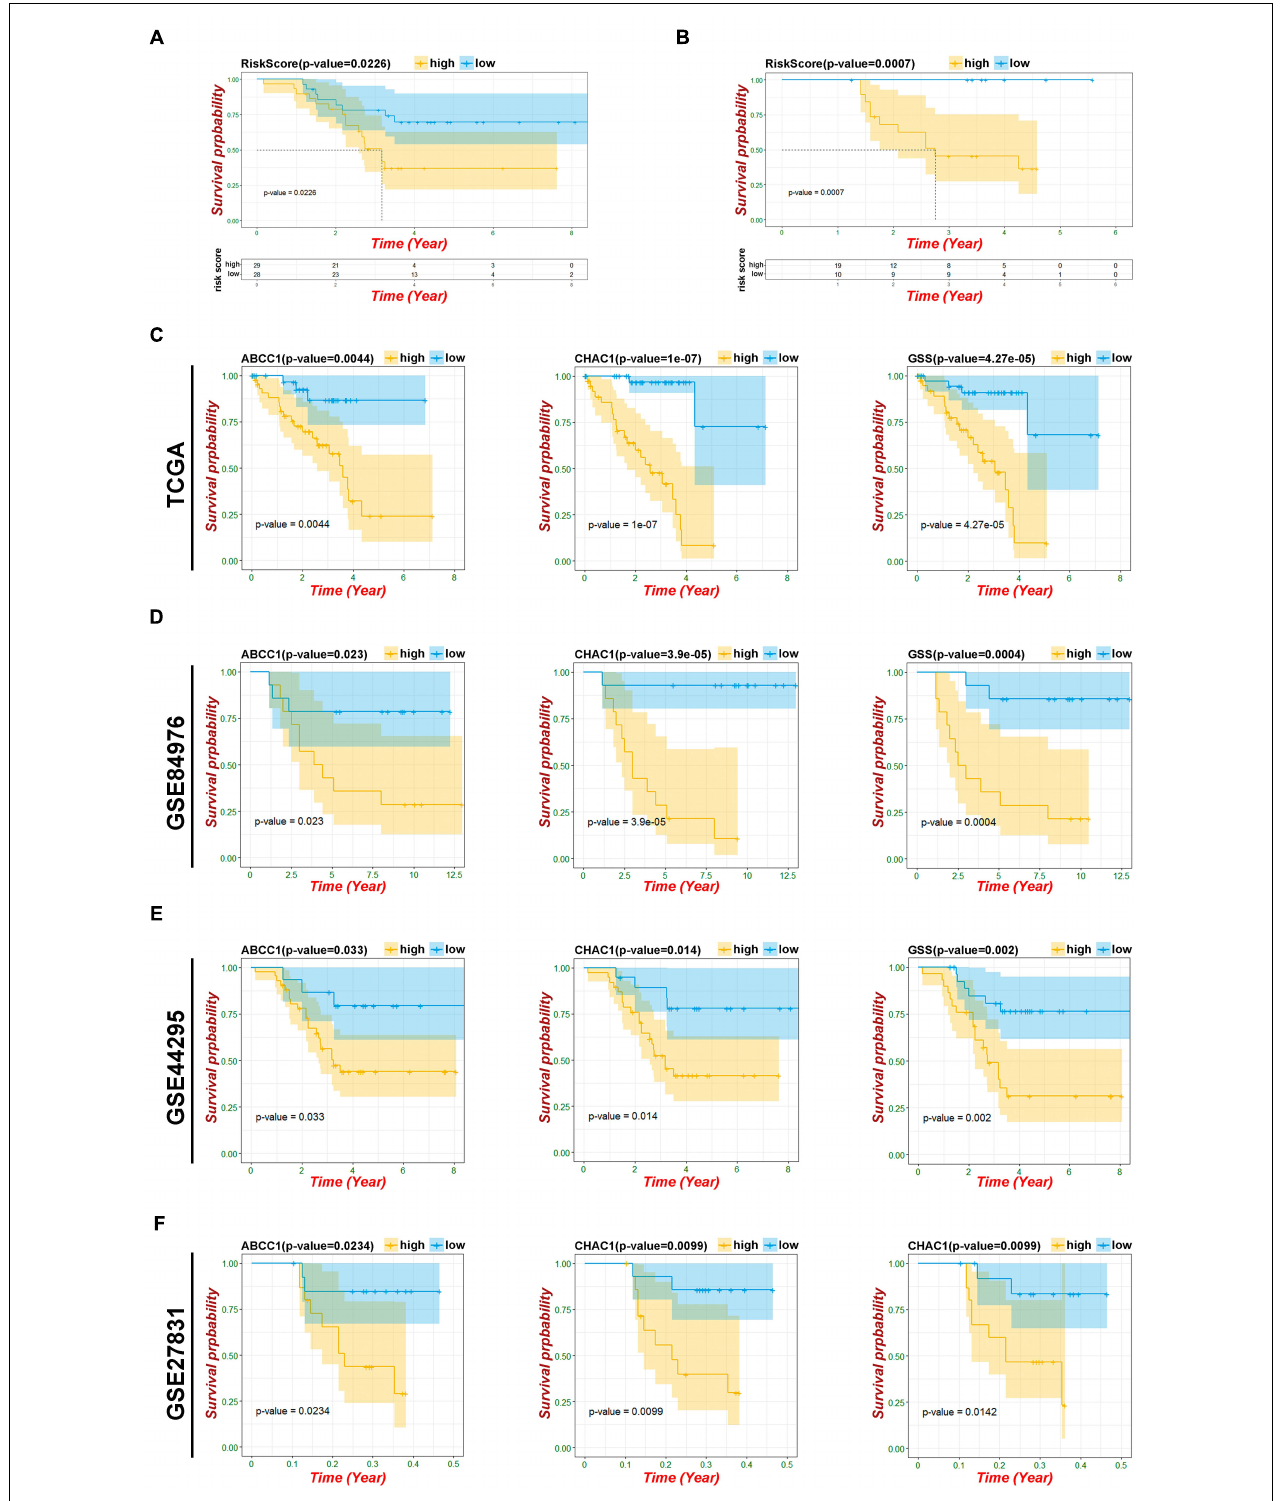
FIGURE 6 | Verification of risk model and ferroptosis-related genes. (A) Kaplan–Meier curves of patients in risk model about OS based on GSE44295. (B) Kaplan–Meier curves of patients in risk model about PFS based on GSE27831. (C) Kaplan–Meier OS curves for patients in key ferroptosis-related genes based on TCGA. (D) Kaplan–Meier OS curves for patients in key ferroptosis-related genes based on GSE84976. (E) Kaplan–Meier OS curves for patients in key ferroptosis-related genes based on GSE44295. (F) Kaplan–Meier PFS curves for patients in key ferroptosis-related genes based on GSE27831.